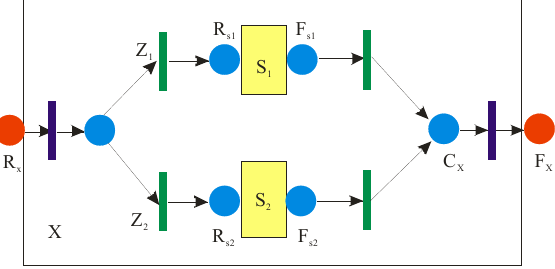
represents BPEL's switch pattern, which contains an ordered set of activities with associated conditions, and executes the contained activity for which the associated condition is satisfied. Fig.4 shows how this can be mapped onto a service net.